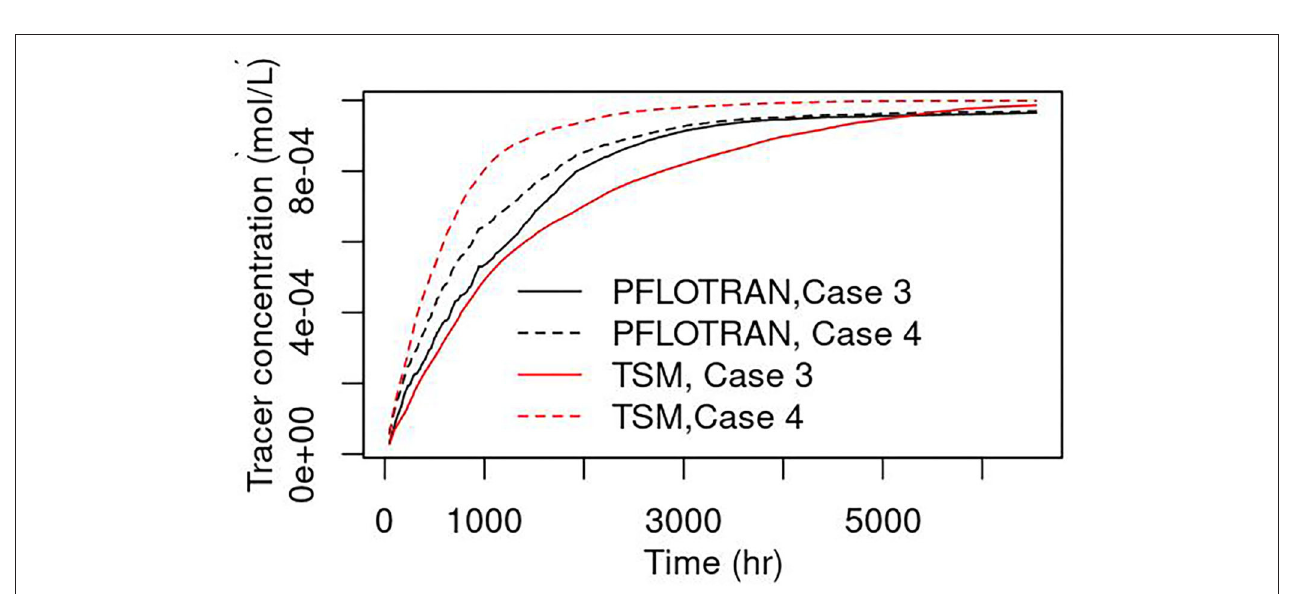
FIGURE 6 | Temporal tracer concentration curves simulated using PFLOTRAN and TSM.